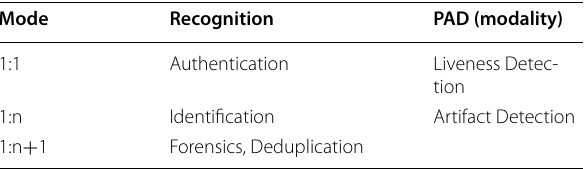
Table 1 Model of how biometric recognition and PAD share the same modes of operation and where a non-exhaustive list of different applications fall in this model Mode